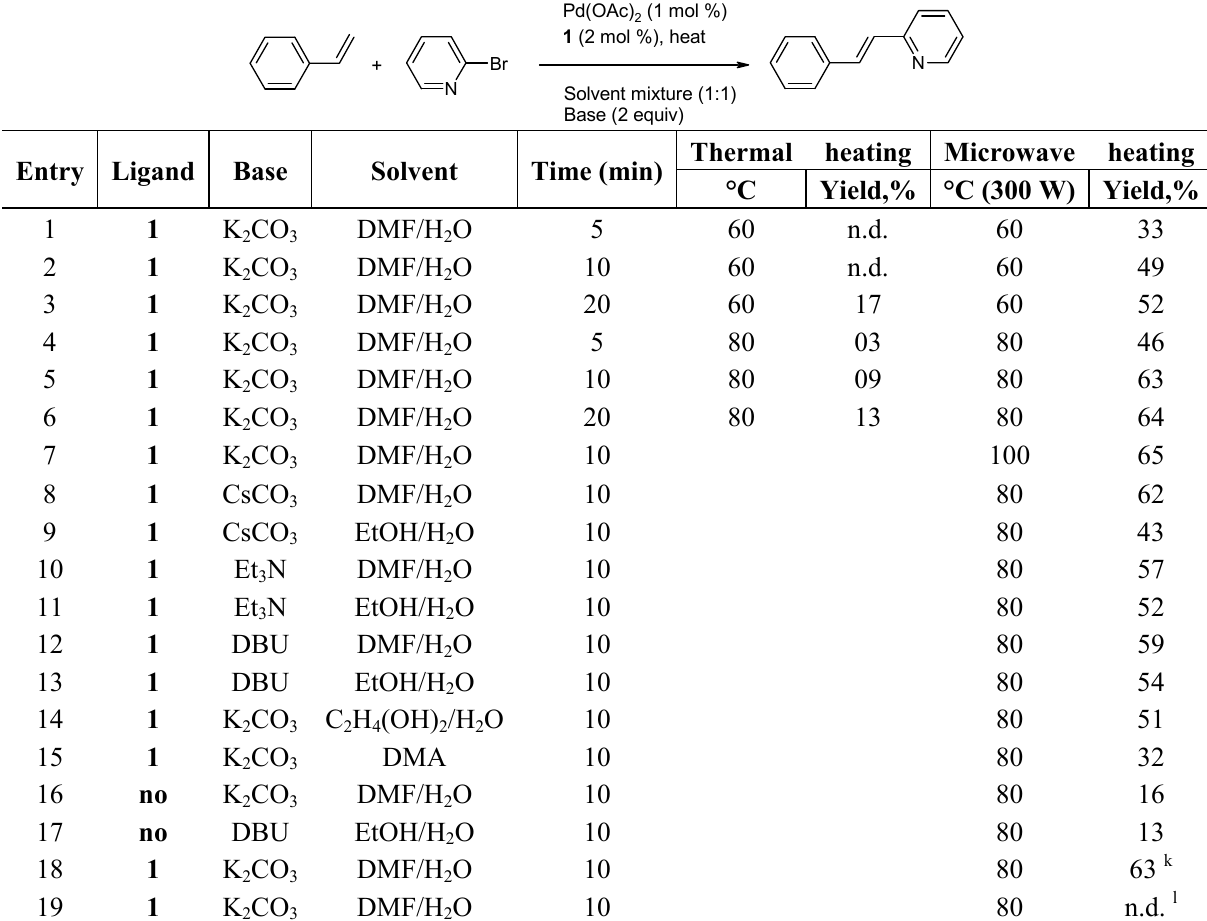
Table 1. Test experiments for optimization of the Heck-Mizoroki coupling reactions.